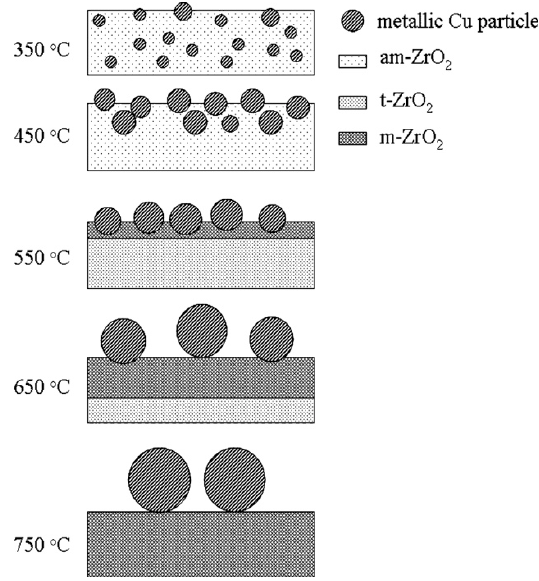
Figure 2. Schematic representation of the influence of the calcination temperature on the phase composition and copper particles size on a copper–zirconia material (https://pubs.acs.org/doi/10.1021/jp075930k) [34]. Reprinted with the permission of the American Chemical Society (ACS); further permissions related to the material excerpted should be directed to the ACS.